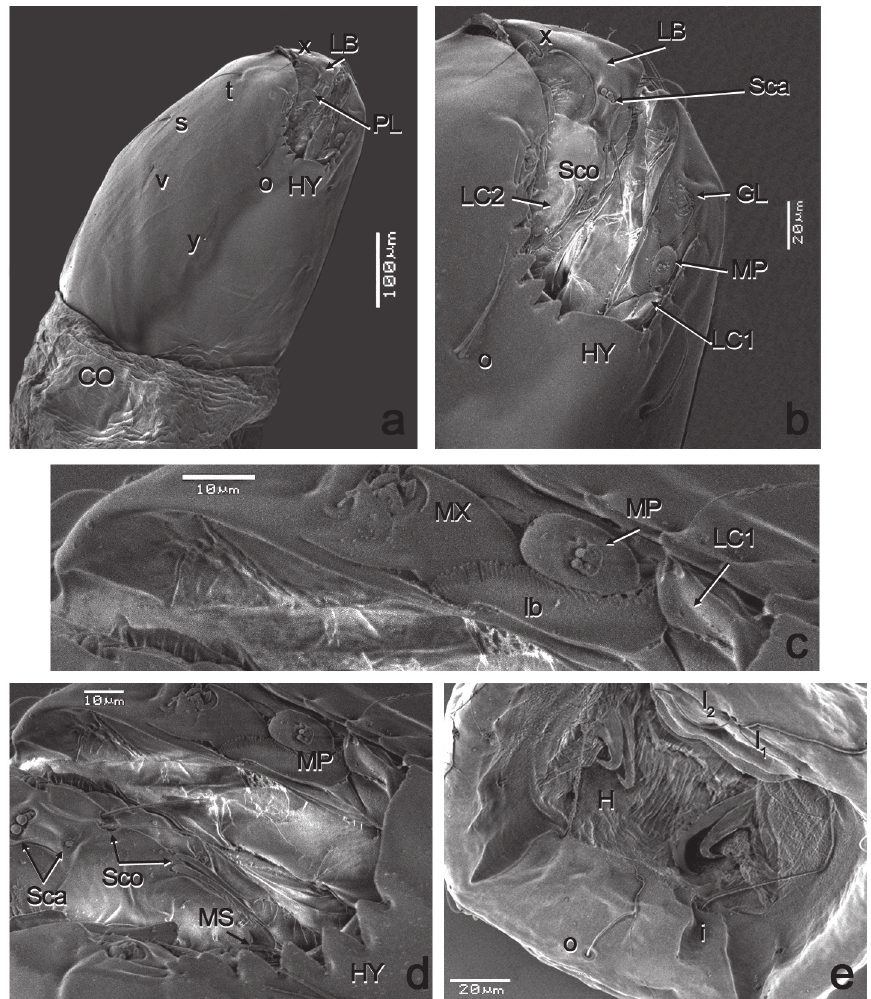
Figure 1a-e - Dasyhelea mediomunda Minaya, larva (SEM). a , head capsule (chaetotaxy, lateroventral view); b , head capsule (details, lateroventral view); c , details of mouthparts (ventral view); d , mouthparts (ventral view); e , caudal segment. Collar (CO); galeolacinia (GL); hypostoma (HY); hooks (H); labrum (LB); lacinial sclerite 1 (LC1); lacinial sclerite 2 (LC2); maxilla (MX); maxillary palpus (MP); messors (MS); palatum (PL); sensilla coeloconica (Sco); sensilla campaniformia (Sca). Head capsule chaetotaxy: o, parahypostomal setae; s, anterior perifrontal setae; t, prefrontal setae; v, posterolateral setae; x, parantennal setae; y, ventral setae. Caudal segment chaetotaxy: o, outer setae; i, inner setae; l